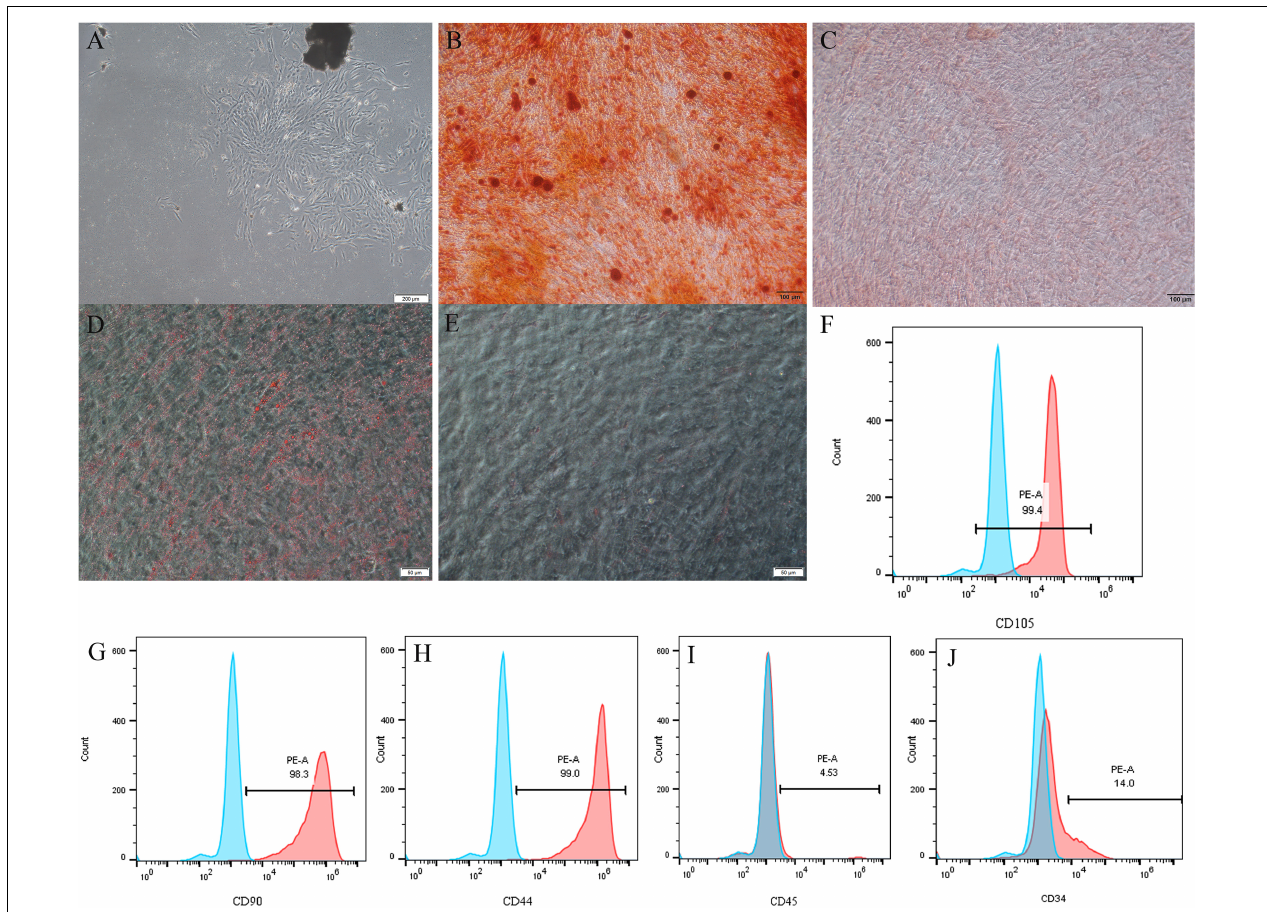
FIGURE 1 | Isolation and characterization of DPSCs. (A) Representative image to display primary DPSCs. (B–E) DPSCs underwent osteogenic/odontogenic and adipogenic differentiation and were stained after 21 days. Alizarin red staining indicated mineralized nodules in the osteogenic/odontogenic group (B) but negative for the control group (C) . Oil red O images indicated oil droplets in the adipogenic group (D) but negative for the control group (E) . DPSCs were positive for mesenchymal stem cells markers CD105 (F) , CD90 (G) , and CD44 (H) , but negative for hematopoietic stem cells markers CD45 (I) and CD34 (J)